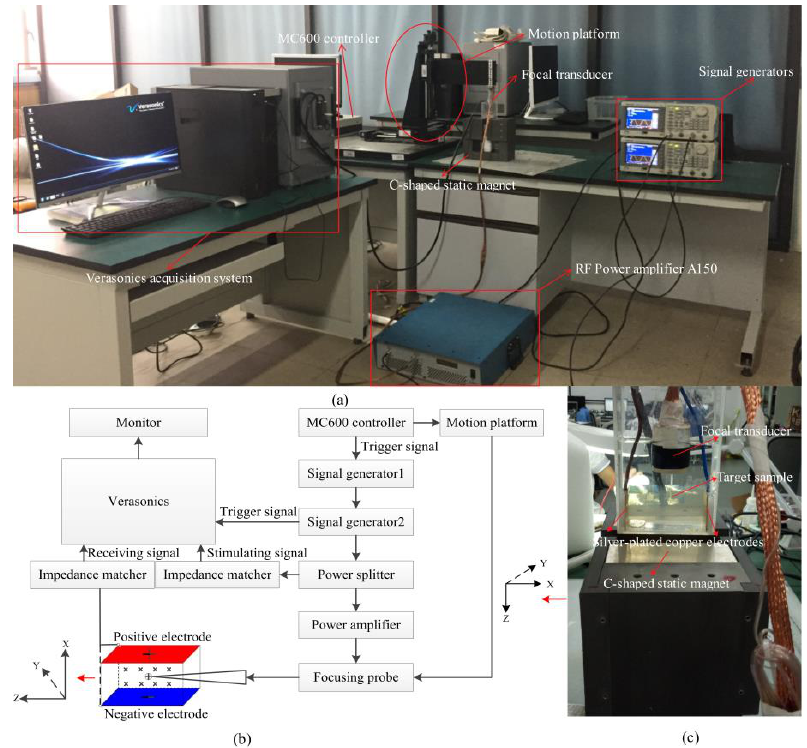
Figure 2. System composition of the MAET-CPS detection system: ( a ) physical diagram; ( b ) connection diagram; and ( c ) the detection front end.